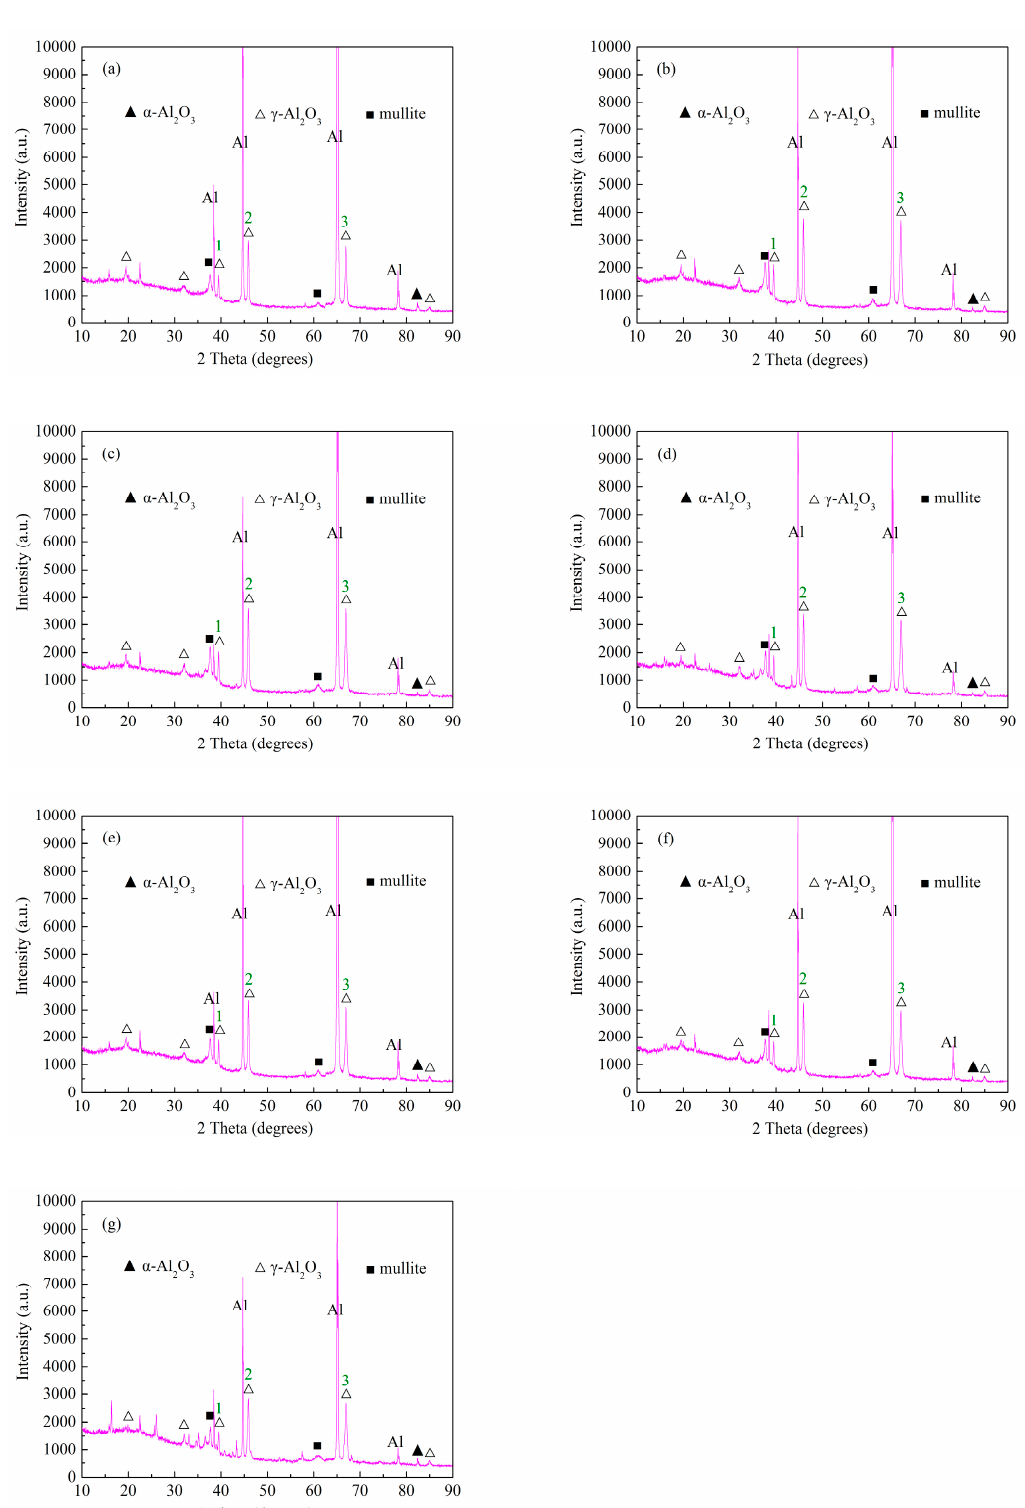
Figure 8. X-ray diffractometer (XRD) patterns of the microarc oxidation coatings formed on aluminum alloys at different anode pulse-widths. ( a ) 1000 μ s; ( b ) 1500 μ s; ( c ) 2000 μ s; ( d ) 2500 μ s; ( e ) 3000 μ s; ( f ) 3500 μ s; ( g ) 4000 μ s.